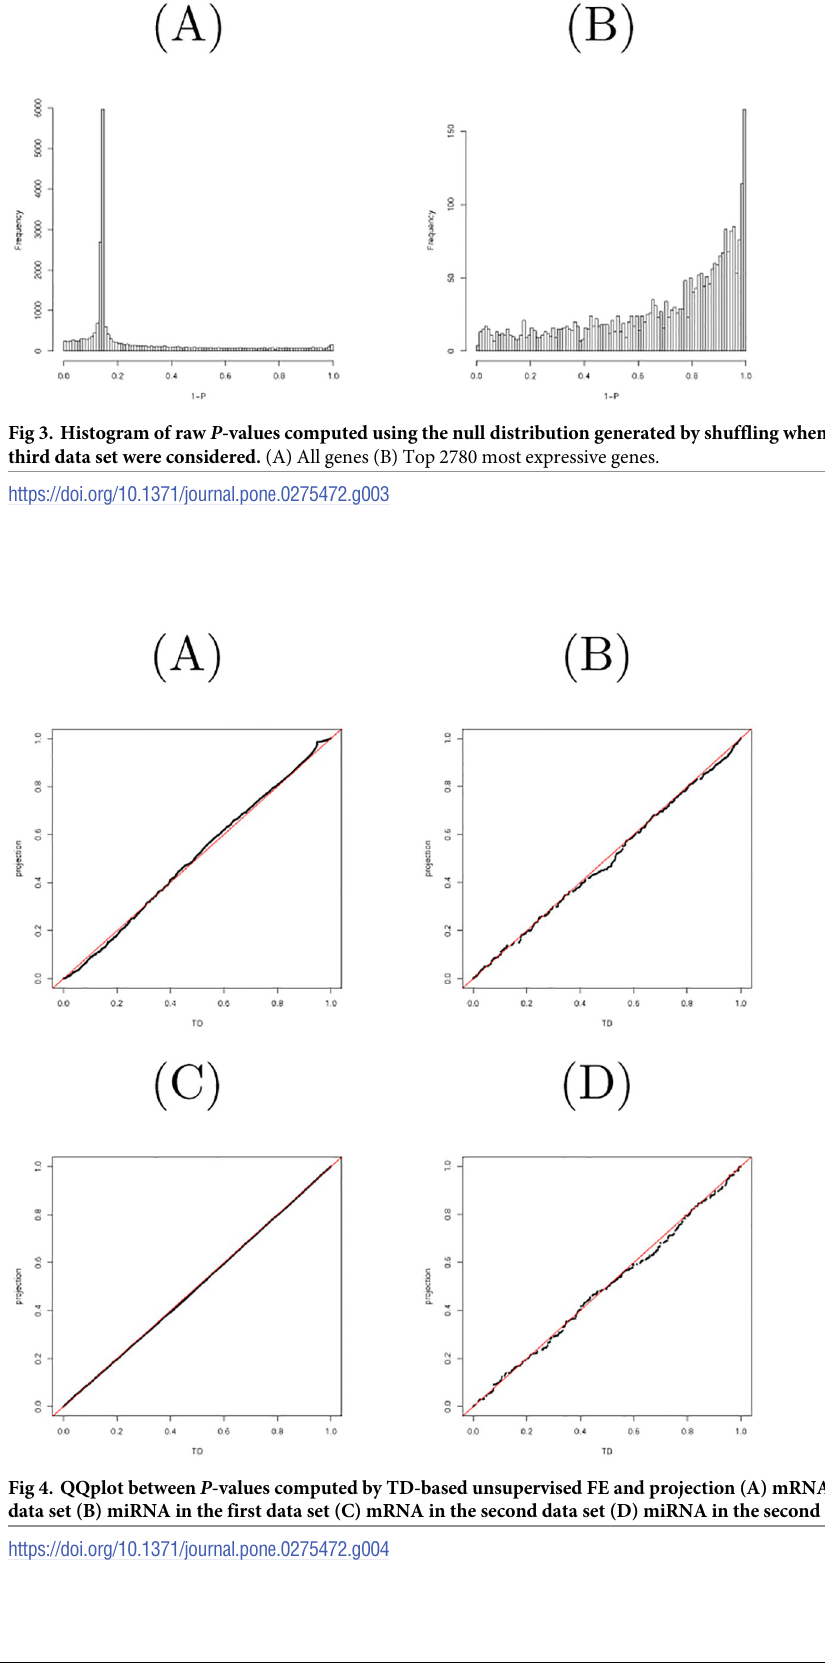
PLOS ONE | https://doi.org/10.1371/journal.pone.0275472 September 29,